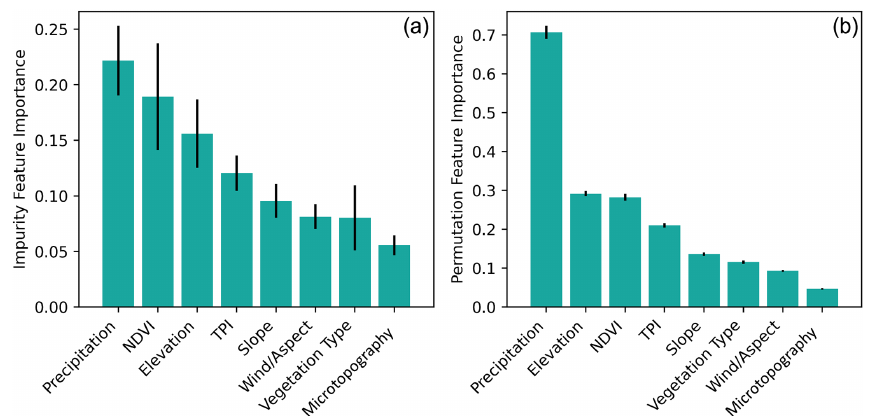
Figure 9. Random forest feature importance results (where panel a shows the impurity, and panel b shows the permutation) for the final model, with ± 1 standard deviation shown by the black error